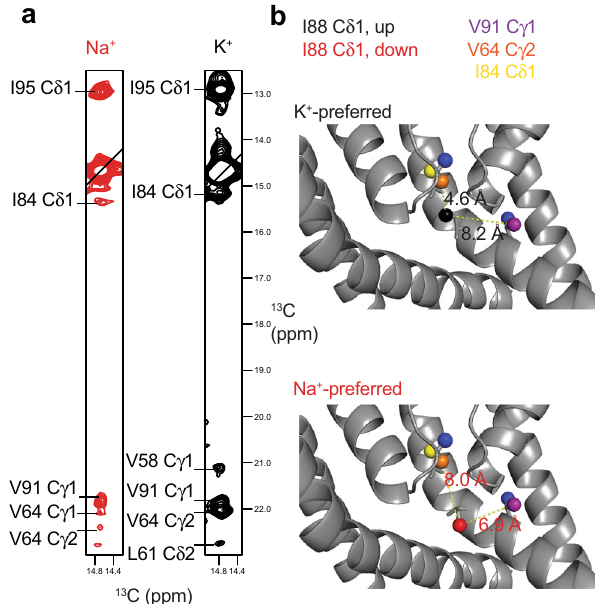
Fig. 5 I88 side chain conformation is ion dependent. a Strips for I88 C δ 1 from 3D CCH NOESY experiments collected in 600 mM Na + (red, 1 H ppm = 0.567) and 100 mM K + (black, 1 H ppm = 0.576). b Distances from I88 C δ 1 to V64 C γ 2 and V91 C γ 1 in the ‘ up ’ (black) and ‘ down ’ (red) conformations. NOESY data collected in K + is consistent with the ‘ up ’ conformation, while the data collected in Na + is more consistent with the ‘ down ’